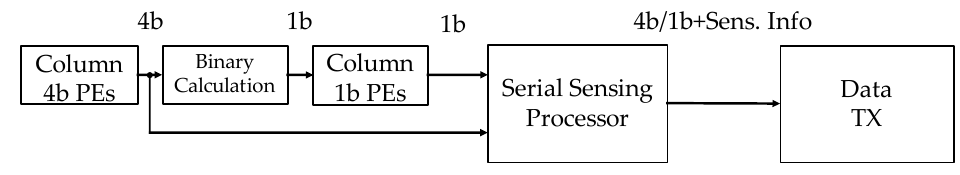
Figure 3. Data flow for sensing.